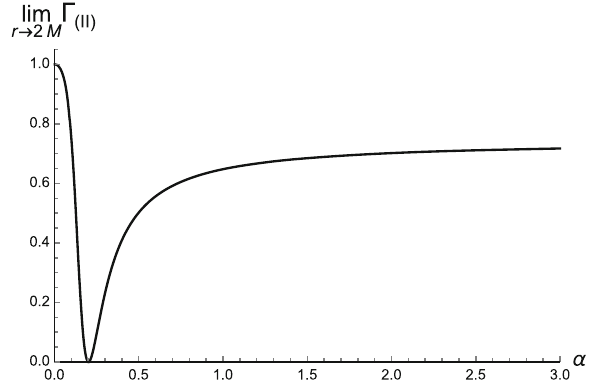
Fig. 2 Plot of lim r → 2 M Γ (II) as a function of the decoupling parameter α